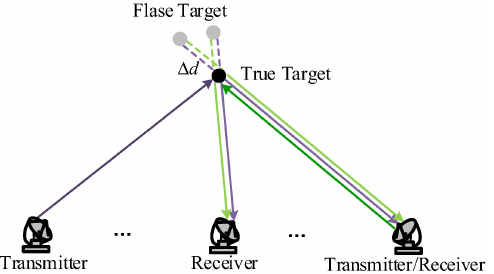
Figure 1. Multistatic radar system with range deception